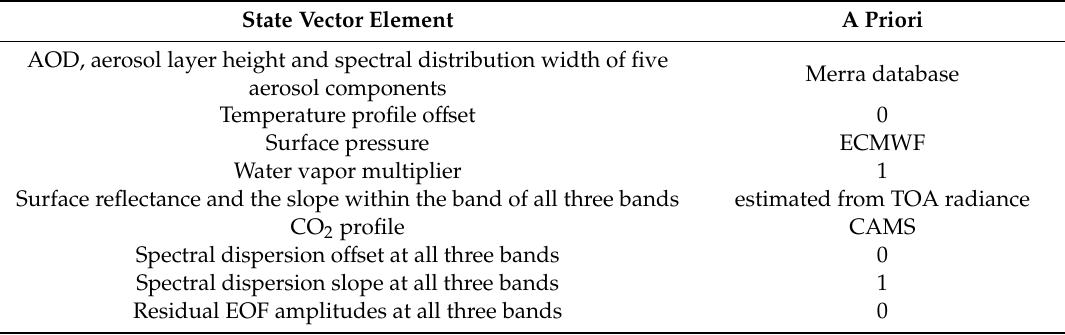
Table 1. The State vector elements and their a priori values used in the retrieval. State Vector Element A Priori AOD, aerosol layer height and spectral distribution width of five Merra database aerosol components Temperature profile o ff set 0 Surface pressure ECMWF Water vapor multiplier 1 Surface reflectance and the slope within the band of all three bands estimated from TOA radiance CO 2 profile CAMS Spectral dispersion o ff set at all three bands 0 Spectral dispersion slope at all three bands 1 Residual EOF amplitudes at all three bands 0 4.